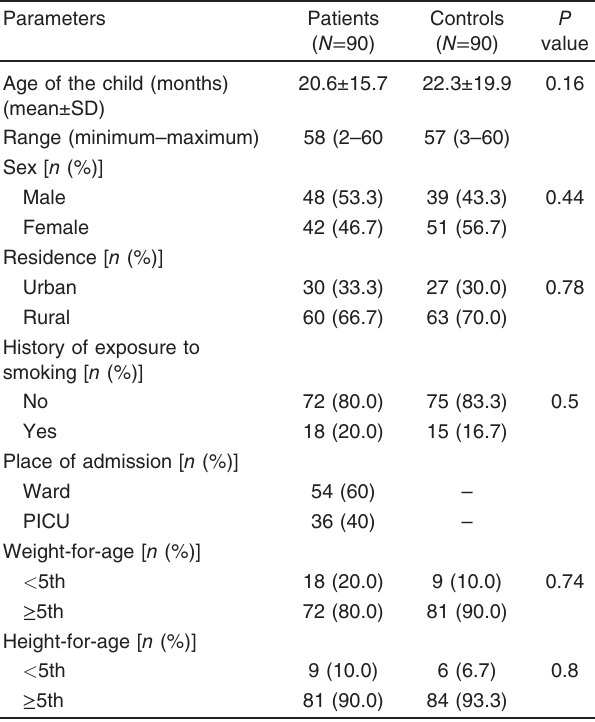
Table 1 Demographic data and anthropometric measurements among patients and control